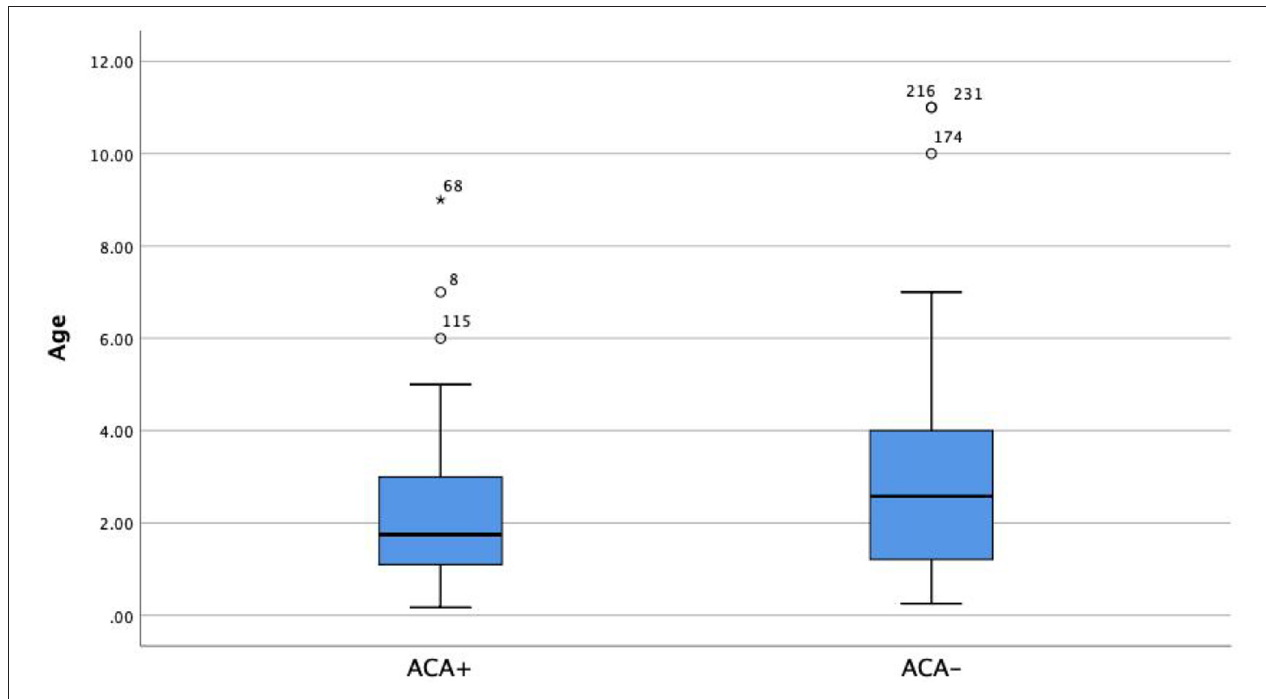
FIGURE 1 | Age difference for ACA + group vs. ACA–